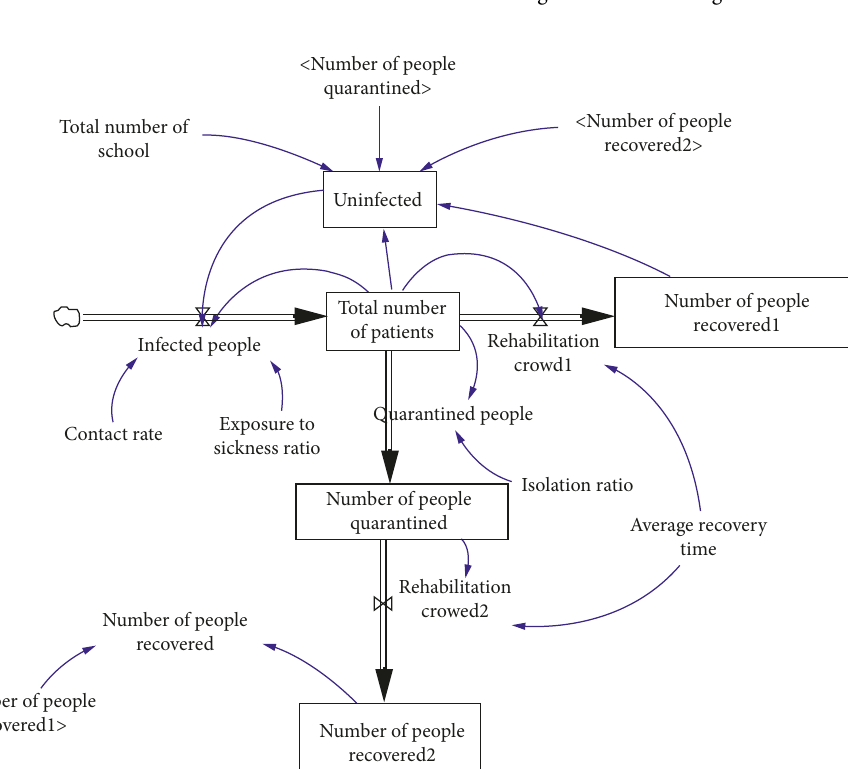
Figure 7: Logical framework diagram of an infection in the third